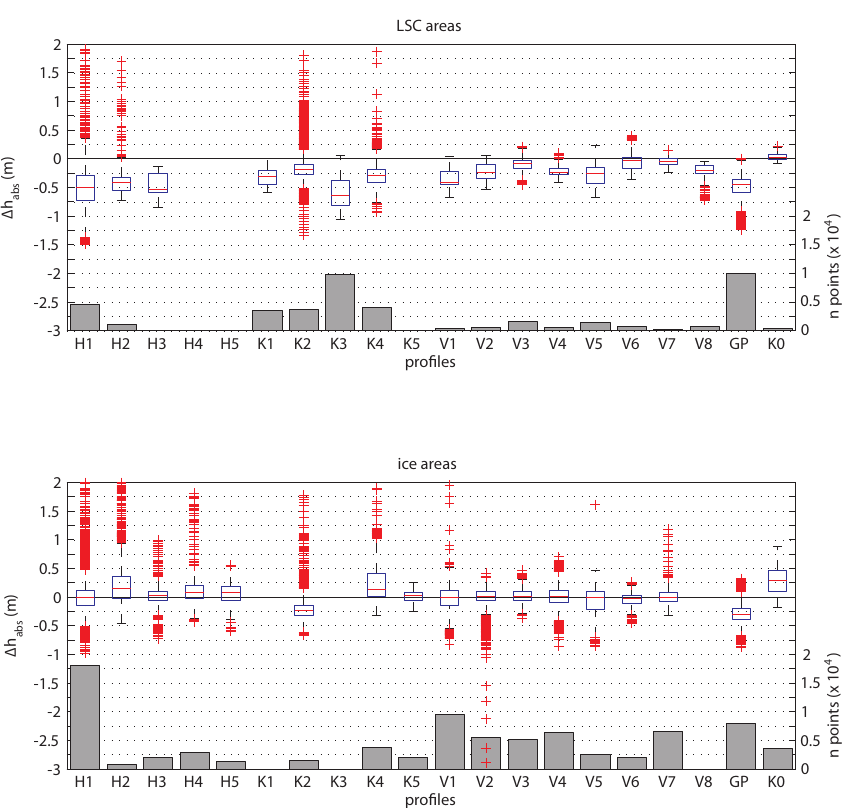
Fig. 10. Box plots of the absolute differences 1h abs at the profiles for snow covered areas derived from Landsat (LSC, upper plot) and ice areas (lower plot) separately. Statistical distribution is shown in terms of the median (red line), the scatter (25% and 75% percentiles, blue box), the range of values within 1.5 times the interquartile range added to the 25% percentile and to the 75% percentile (black whiskers) and the outliers (red crosses). The number of points included in the statistics are plotted as grey bars (right